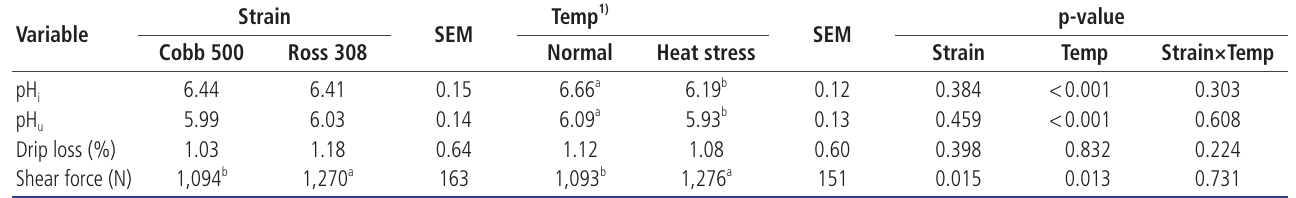
), ultimate pH (pH i